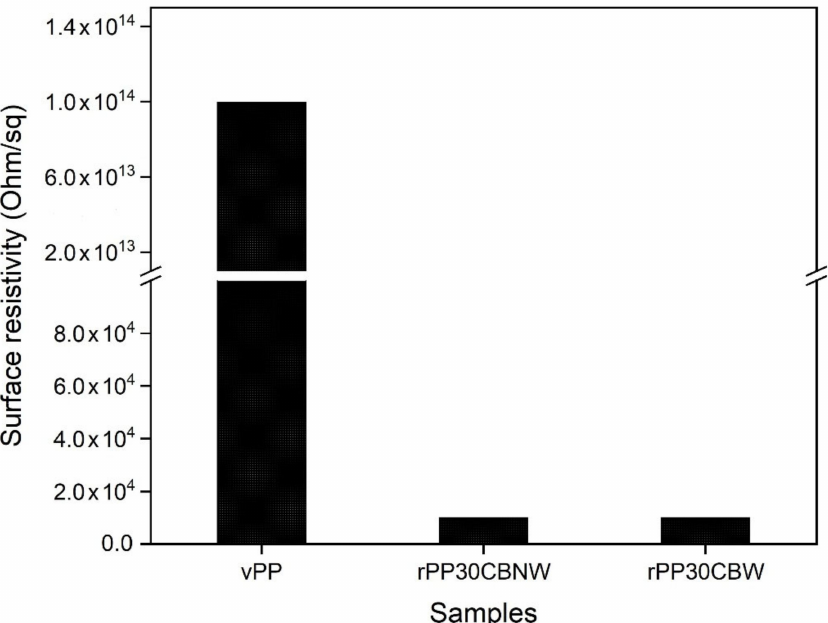
Figure 10. Comparison of the surface resistivity of the neat PP and the obtained rPP composites with and without the plasticizer